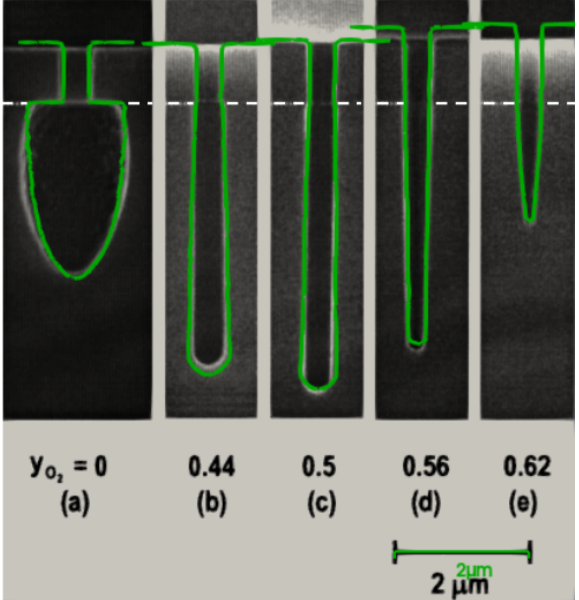
Figure 3. Diagonal slices through a 3D-simulated (green) and SEM cross sections of cylindrical hole profiles from Belen et al.[25] (black). The increasing presence of O 2 hinders lateral etching while initially enhancing vertical etching ( a – c ). Further increasing the O 2 flux leads to negative sidewall tapering and a reduction in the vertical etching ( d , e ). The oxide mask–Si interface is depicted with a white dashed line. (Reprinted with permission from[25]). Copyright 2005, American Vacuum